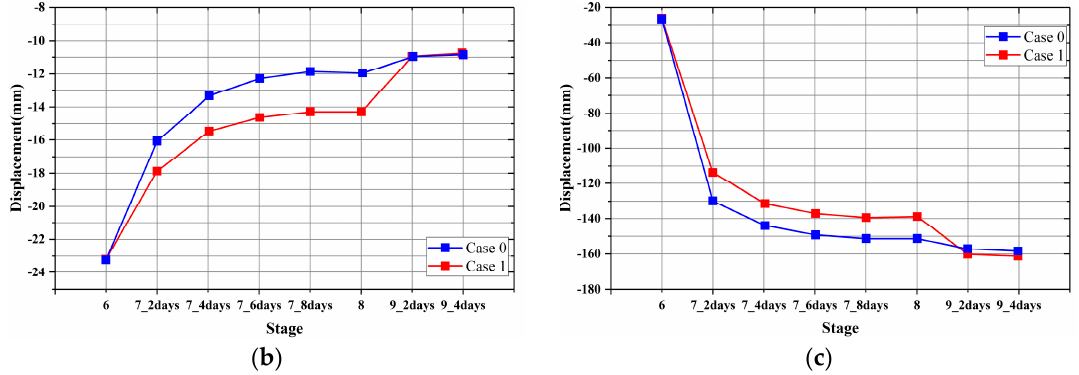
Figure 15. The displacement of supporting structures. ( a ) Monitoring lining points plot; ( b ) horizontal displacement of the bench; ( c ) relative vertical displacement changes.